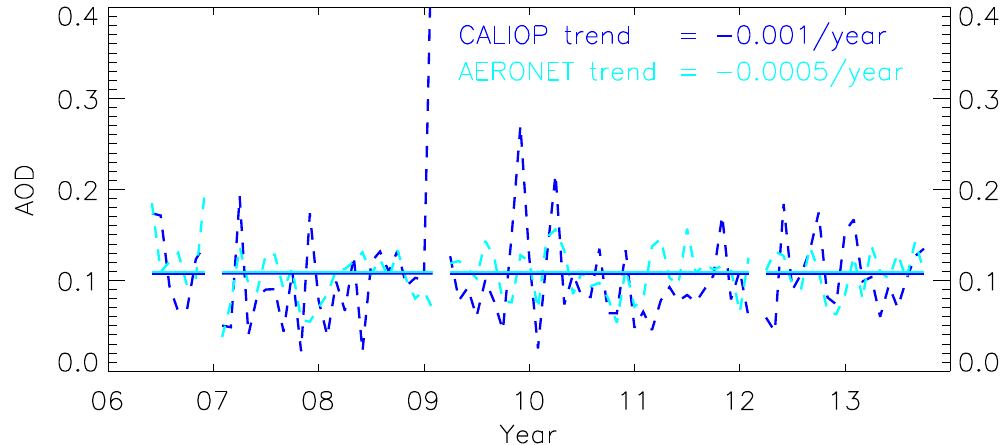
Figure 13. Monthly averaged over ocean clear-sky AODs derived from collocated CALIOP and AERONET data. CALIOP retrievals within 0.3 ◦ latitude and longitude and ± 30min of the corresponding AERONET station and observation are considered collocated. AERONET and CALIOP AODs above 0.2 and 0.6, respectively, are not included in order to avoid high aerosol loading cases and exclude noisy CALIOP data.